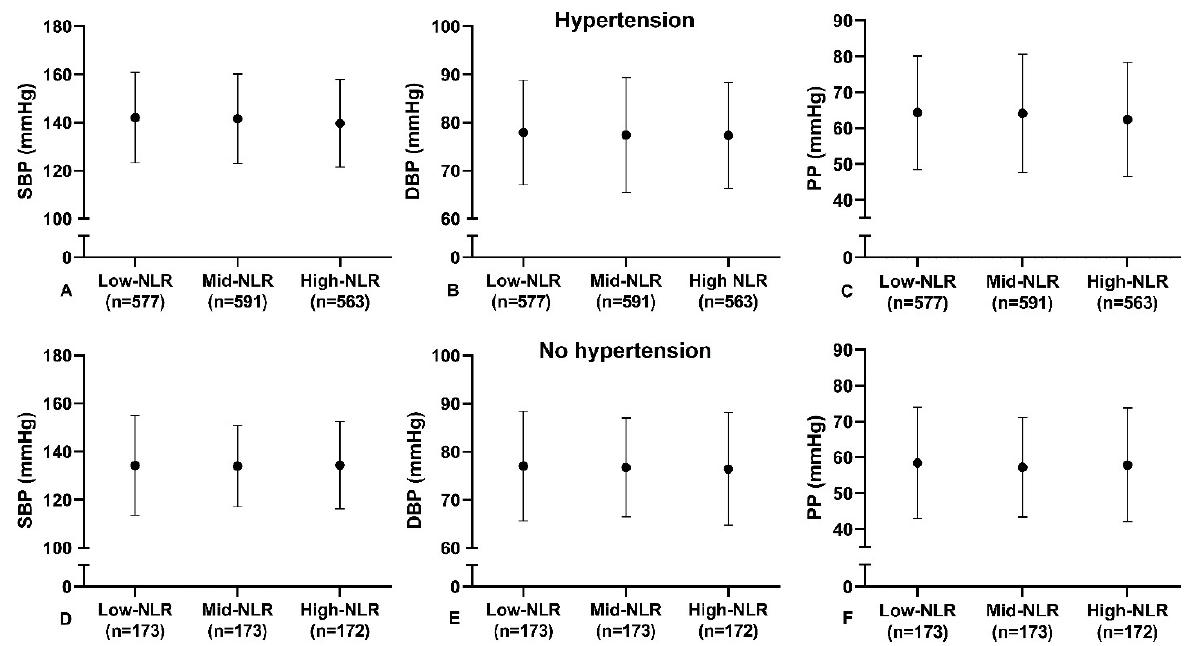
Figure 2. Mean values of blood pressure across tertiles of NLR in individuals with hypertension ( A – C ) and no hypertension ( D – F ). Dots represent mean values, bars represent standard deviation. Figure A and D , systolic blood pressure (SBP) in mmHg; Figure B and E , diastolic blood pressure (DBP) in mmHg; Figure C and F pulse pressure (PP) in mmHg.